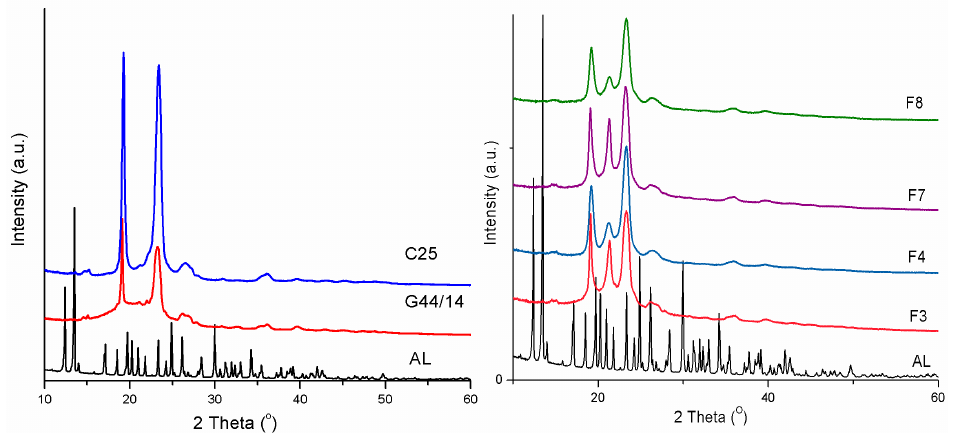
Figure 5. Powder XRD patterns recorded on pure AL, Cremophor, Gelucire (left) and formulations F3, F4, F7, F8 (right).